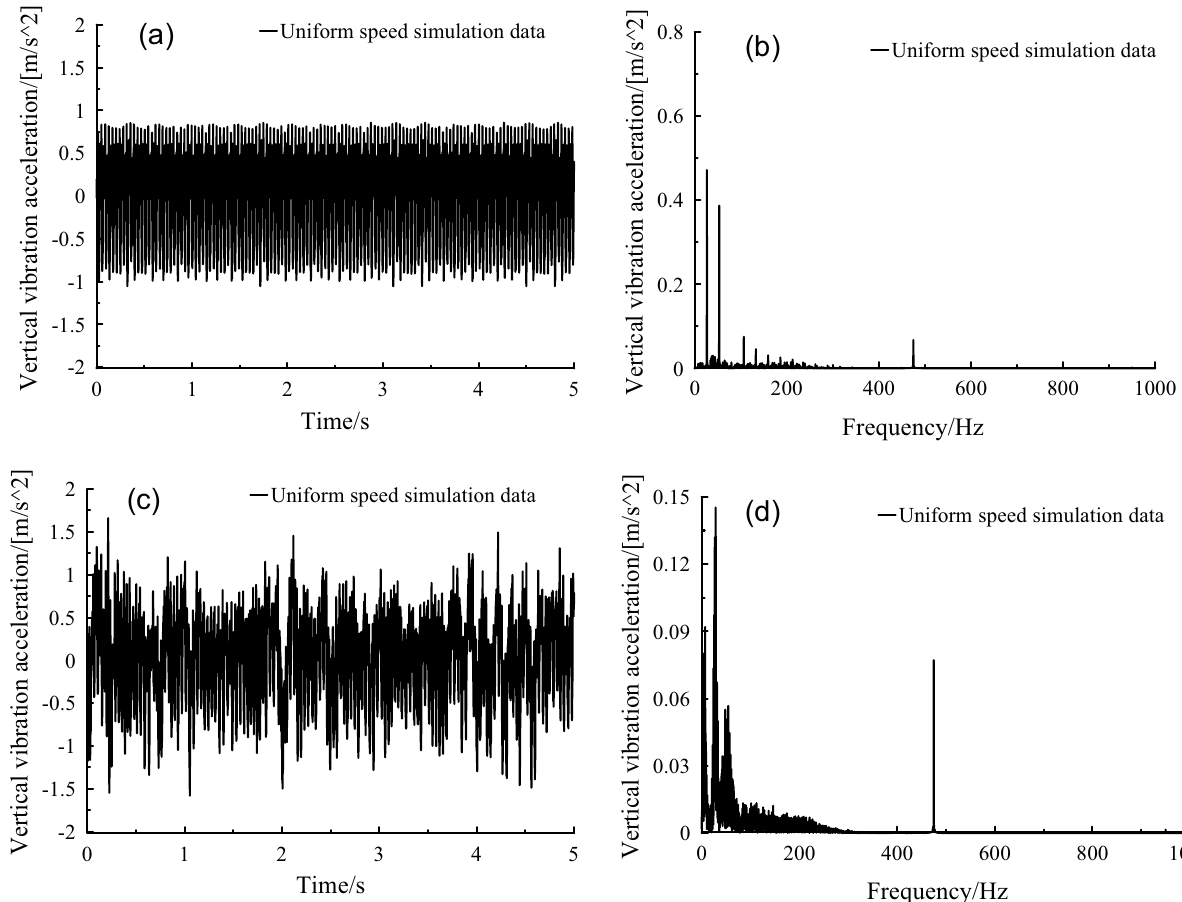
Figure 9. Frame vertical vibration acceleration, (a-b) orbit free spectrum, (c-d) orbital